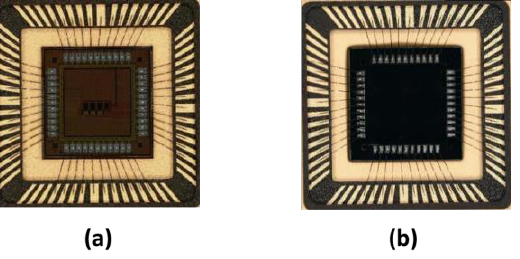
Figure 6. Photographs of the BSB1 chip: ( a ) front-side illuminated (FSI) variant; ( b ) back-side illuminated (BSI) variant. Die size is 5 mm × 5 mm.